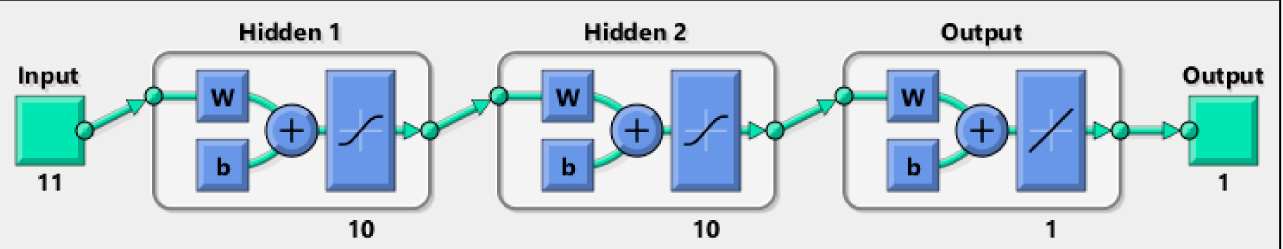
Figure 1. A schematic of the developed ANN